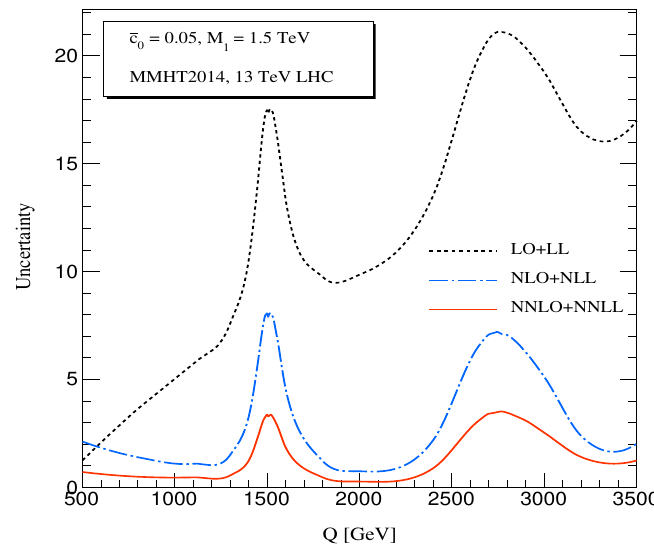
Figure 10 . 7-point scale uncertainties in the signal are shown up to NNLO+NNLL for di-lepton invariant mass distribution.